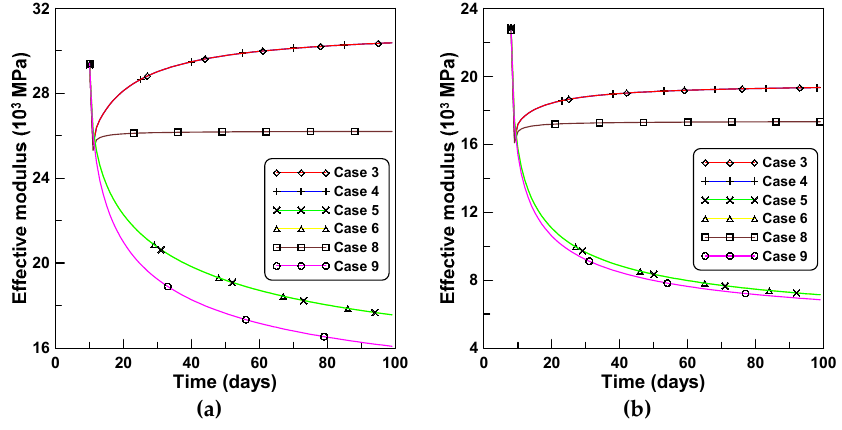
Figure 12. Effective moduli of six constitutive formulations: ( a ) analysis of case A and ( b ) analysis of case B.